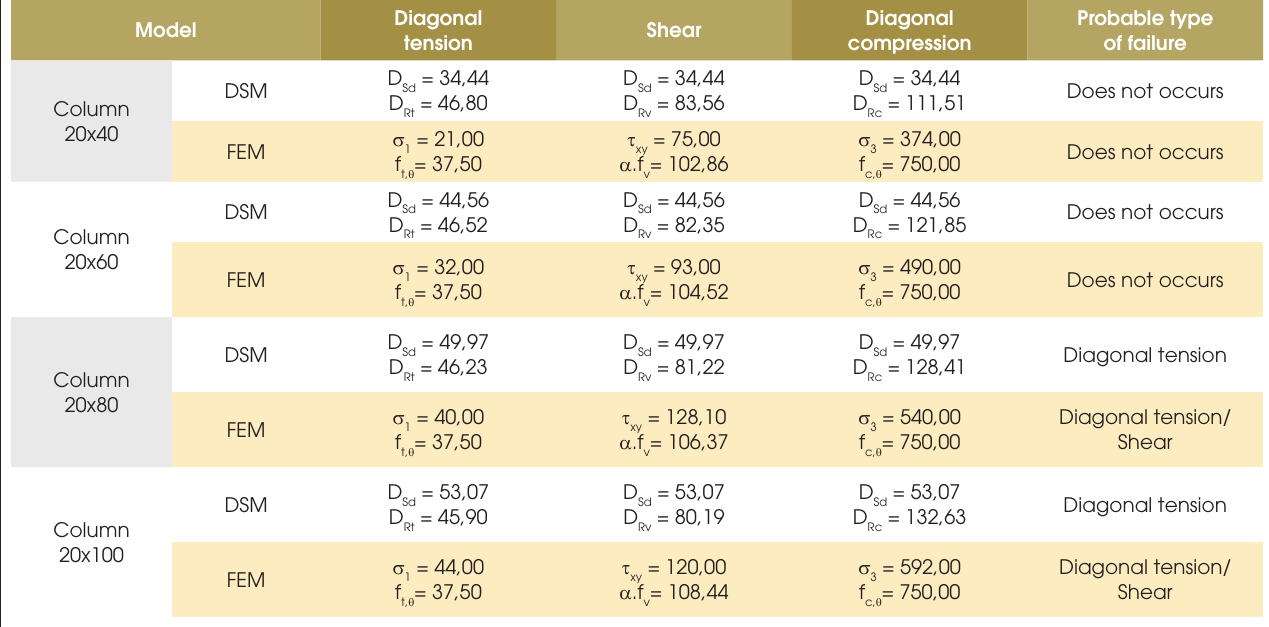
Table 2 – Summary of the results of the Example 1 – Maximum Internal Forces (Stresses) vs.